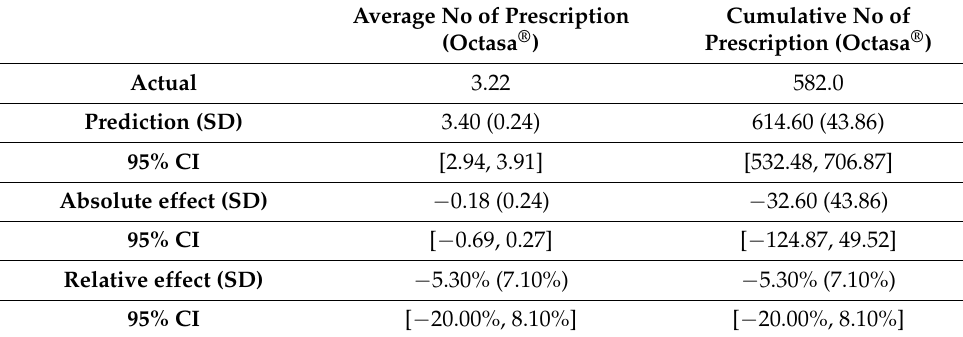
Table 3. Summary statistics—Causal Impact Analysis (pre-intervention 1 vs. intervention 1) for Octasa ® .